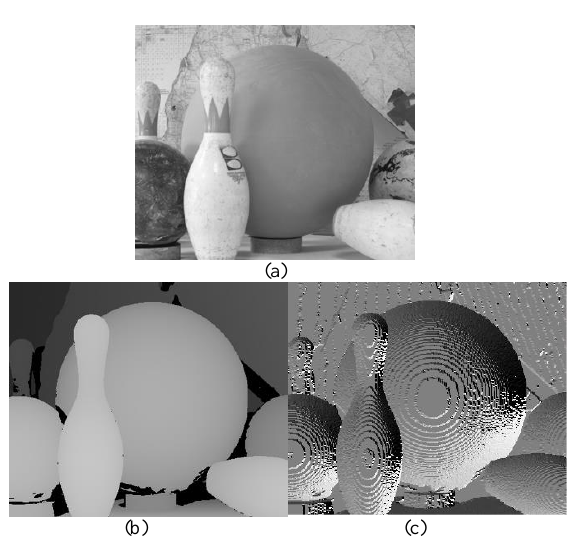
Figure 2. (a) Captured scene by a rectified camera setup [11] (b) Associated disparity map (c) Intersection of iso-disparity layers with object